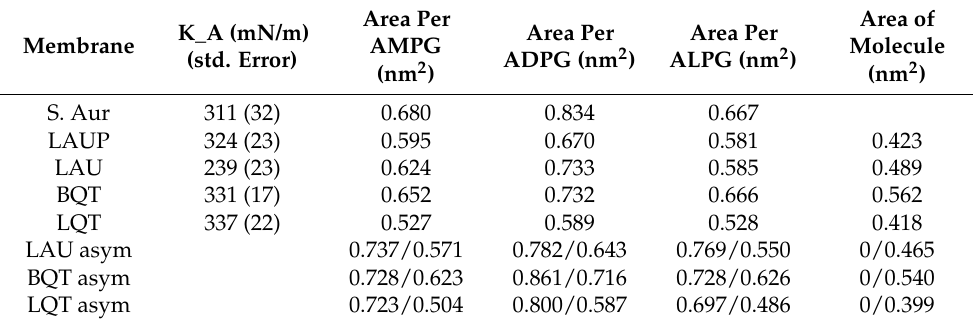
Table 1. Areas per lipid and compressibility modulus for the membranes. For the asymmetric membranes, we report the areas for the upper/lower leaflets. Area K_A (mN/m) Membrane (std. Error)